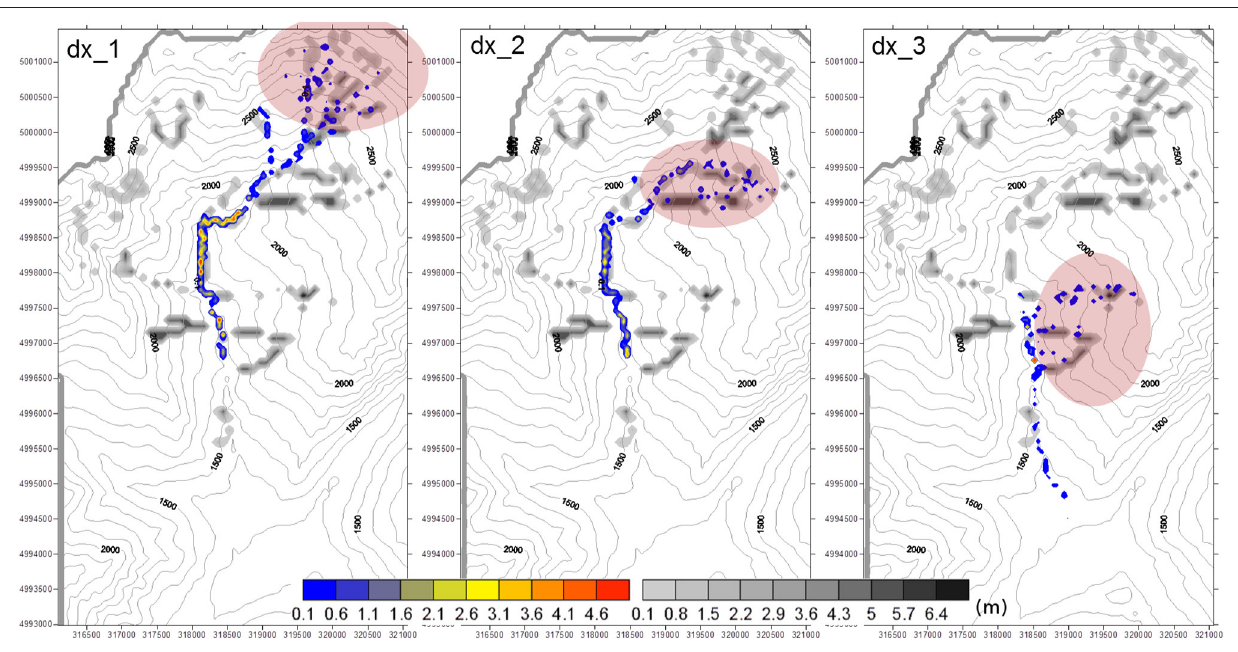
FIGURE 12 | Results of the numerical runs performed in the East area. Colored scale: simulated deposition patterns. Gray scale: initial deposits of